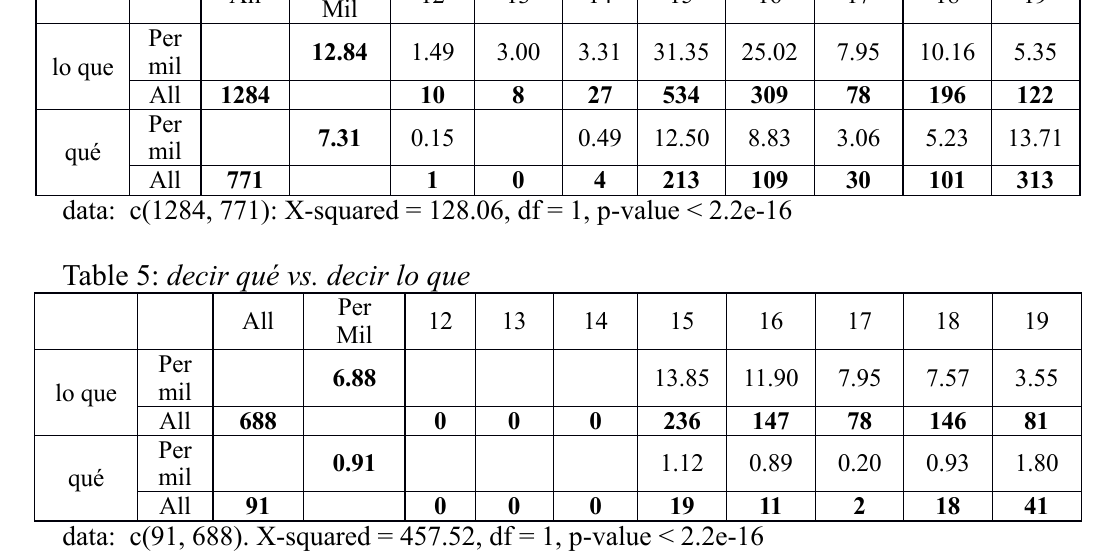
Table 6: no sé lo que vs. no sé qué